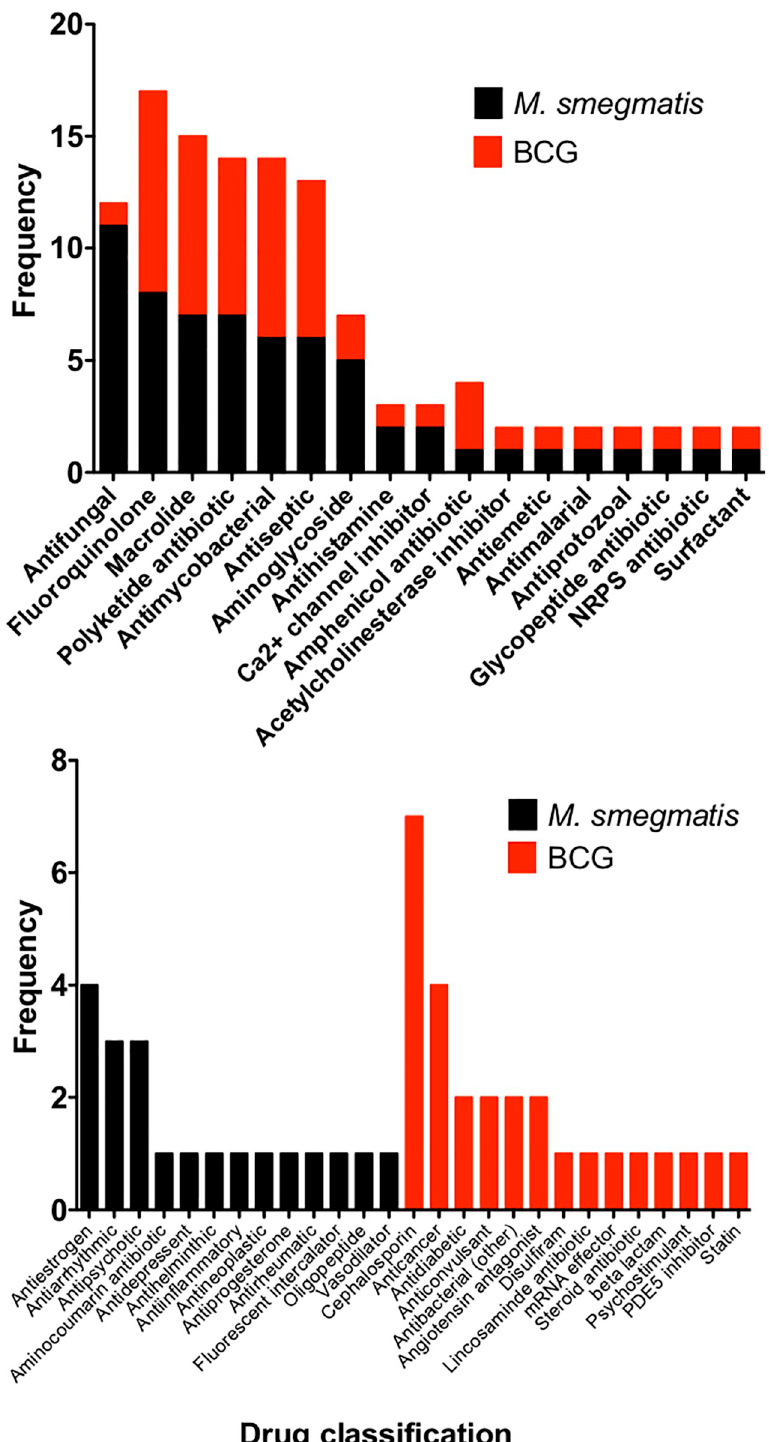
Fig 4. Comparison of the hits emerging from the primary screen active against both M . smegmatis and BCG. Drugs were grouped into drug classifications and are plotted as frequency of hits against either M . smegmatis or BCG.